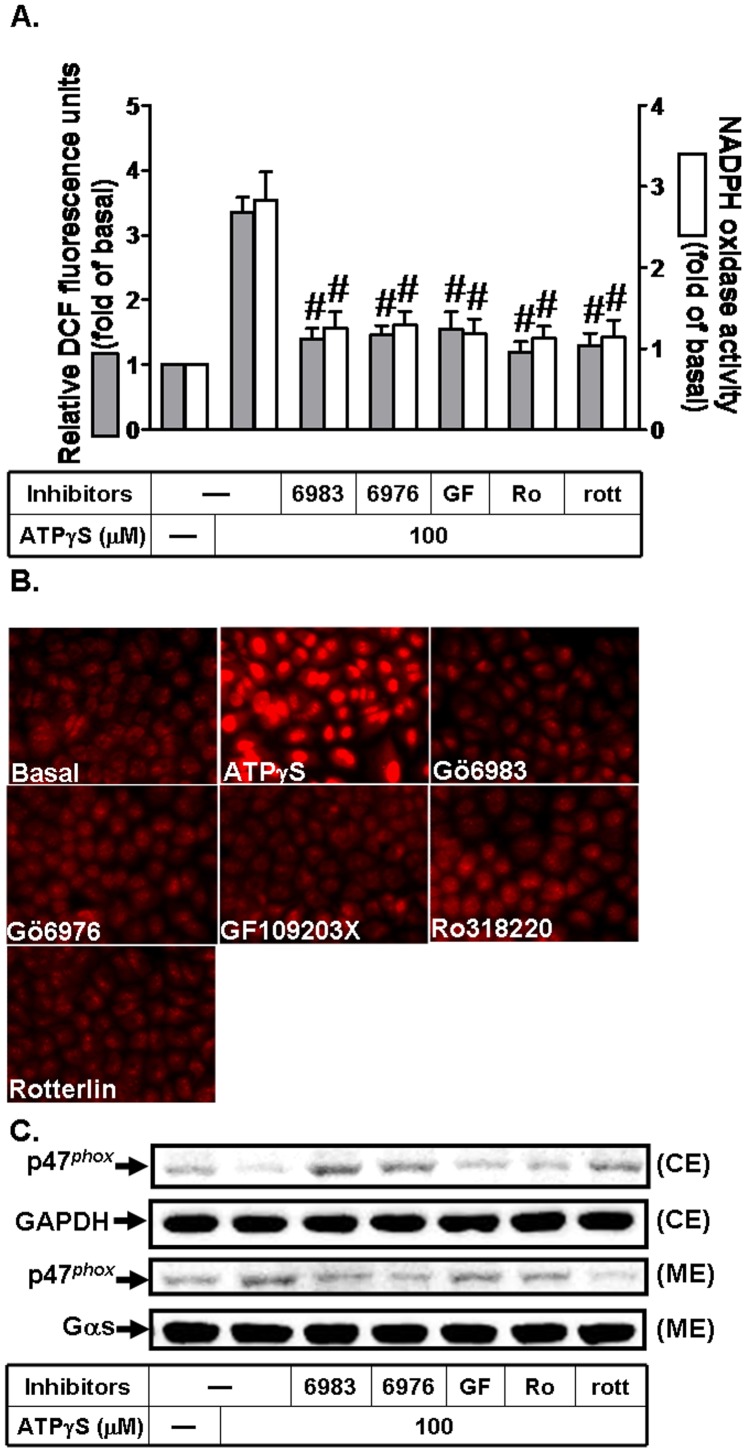
ATPγS induces PKC-dependent ROS generation in A549 cells.(A) Cells were labeled with DCF-DA (10 µM), pretreated with Gö6983 (10 µM), Gö6976 (10 µM), GF109203X (3 µM), Ro318220 (10 µM), or Rottlerin (10 µM) for 1 h, and then incubated with ATPγS for 1 h. The fluorescence intensity (relative DCF fluorescence) was measured (gray bar). In addition, NADPH oxidase activity was determined (white bar). (B) Cells were pretreated with Gö6983 (10 µM), Gö6976 (10 µM), GF109203X (3 µM), Ro318220 (10 µM), or Rottlerin (10 µM) for 1 h, and then incubated with ATPγS for 1 h. After incubation, ROS generation was determined by using CellROX™ Deep Red Reagent as described in Fig. 2E. (C) Cells were pretreated with Gö6983 (10 µM), Gö6976 (10 µM), GF109203X (3 µM), Ro318220 (10 µM), or Rottlerin (10 µM) for 1 h, and then incubated with ATPγS for 1 h. The membrane and cytosolic fractions were prepared and analyzed by western blot using an anti-p47phox antibody. Data are expressed as mean±S.E.M. of three independent experiments. #
p<0.01, as compared with the cells exposed to ATPγS alone.